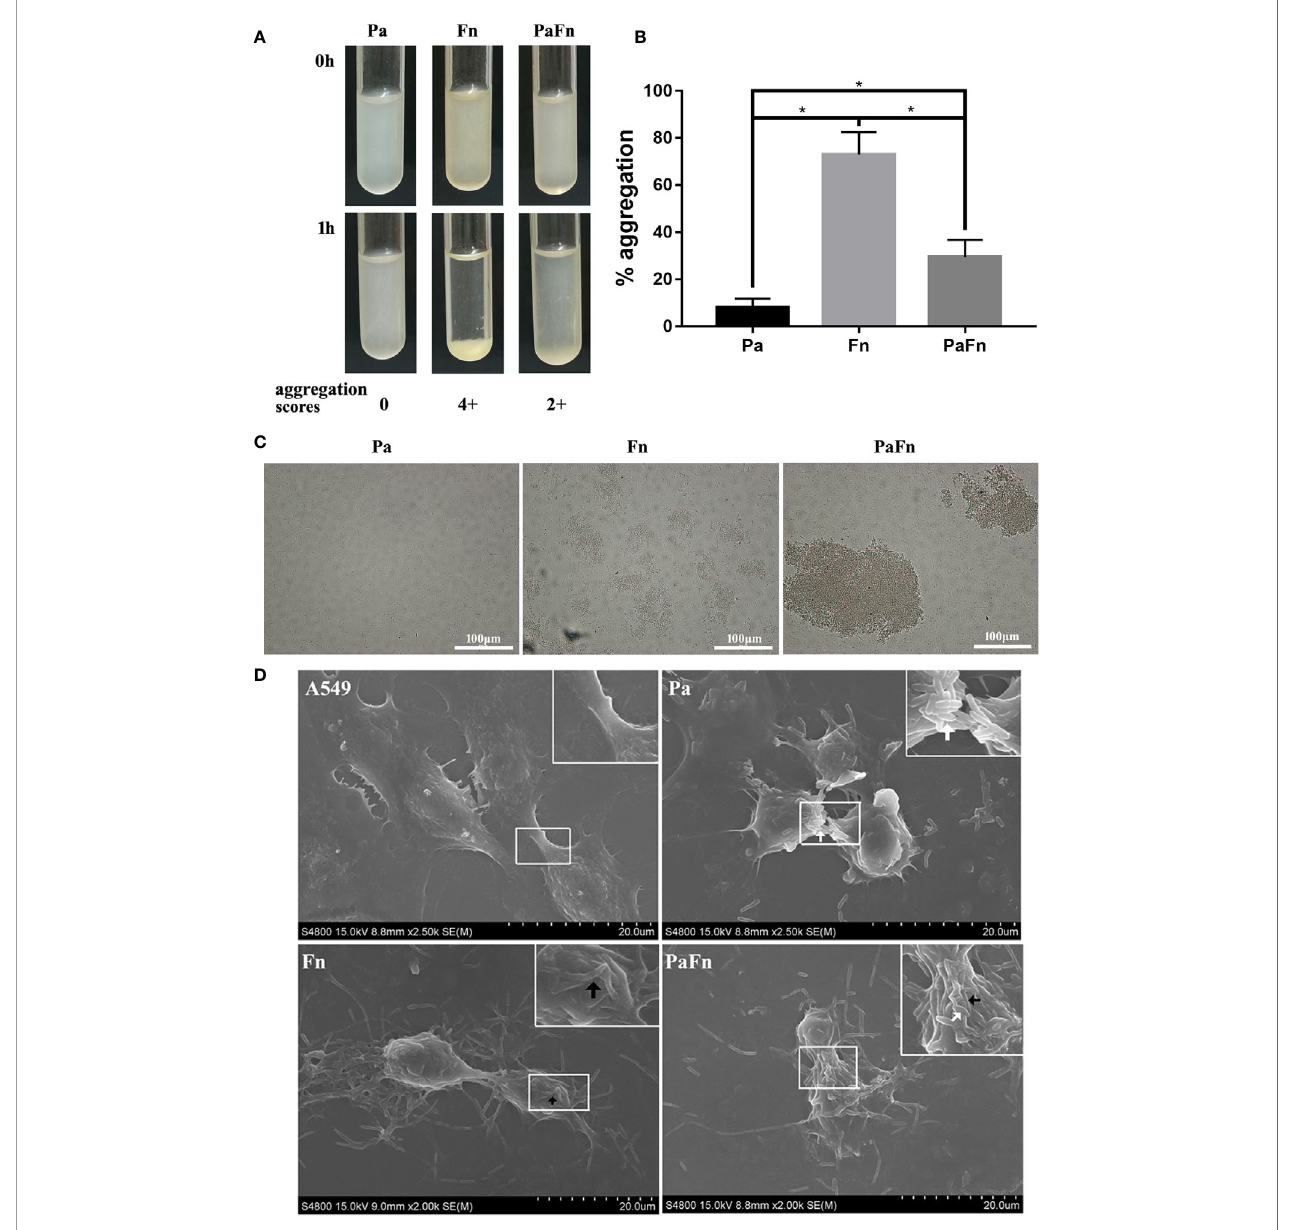
FIGURE 1 | F. nucleatum coaggregates with P. aeruginosa and adheres to pulmonary epithelial cells. (A) Photographs of autoaggregation and coaggregation of P. aeruginosa and F. nucleatum . The aggregation score of each bacterial group was indicated below the photograph. (B) Percentage aggregation of P. aeruginosa and F. nucleatum . * P < 0.05, statistics were achieved by analysis of variance followed by Tukey ’ s multiple comparisons test. (C) Representative images of auto- and coaggregation of P. aeruginosa and F. nucleatum observed by phase contrast microscope. (D) Representative SEM images of pulmonary epithelial cells infected with P. aeruginosa and F. nucleatum alone or together. A549 cells were infected with P. aeruginosa (MOI 100) and F. nucleatum (MOI 100) alone or together for 3 h. White arrow indicates P. aeruginosa , and black arrow indicates F. nucleatum . Pa, P. aeruginosa ; Fn, F. nucleatum cytotoxicity of pulmonary epithelial cells, but enhanced the proliferation of pulmonary epithelial cells, which were infected by proliferation of pulmonary epithelial cells ( Figure 3A ). When the F. nucleatum at MOI of 100 at 8 h ( Figure 3B ). However, when MOI of P. aeruginosa were 50 and 100, P. aeruginosa signi fi cantly pulmonary epithelial cells were simultaneously infected with P. induced cytotoxicity of pulmonary epithelial cells, and the aeruginosa and F. nucleatum , cell proliferation activity was lower cytotoxicity increased with the extension of infection time than the single F. nucleatum -infected groups but higher than the ( Figure 3A ). In contrast, F. nucleatum had no effect on the